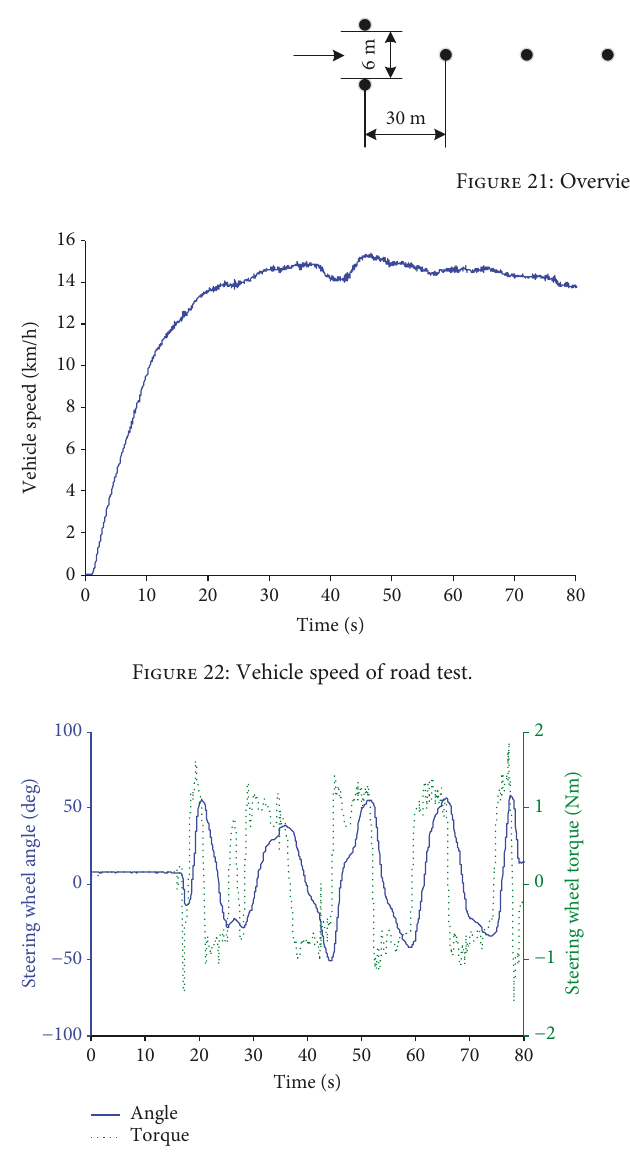
Figure 23: Steering wheel torque and angle.